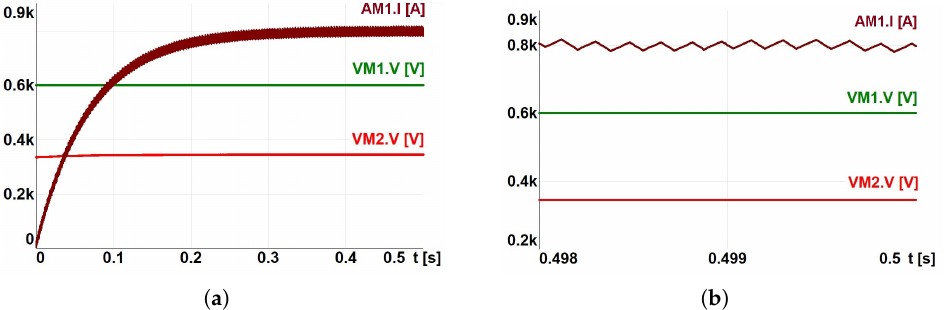
Figure 11. Constant-current battery charging measured in the time interval up to ( a ) 0.5 s, ( b ) 2 ms.